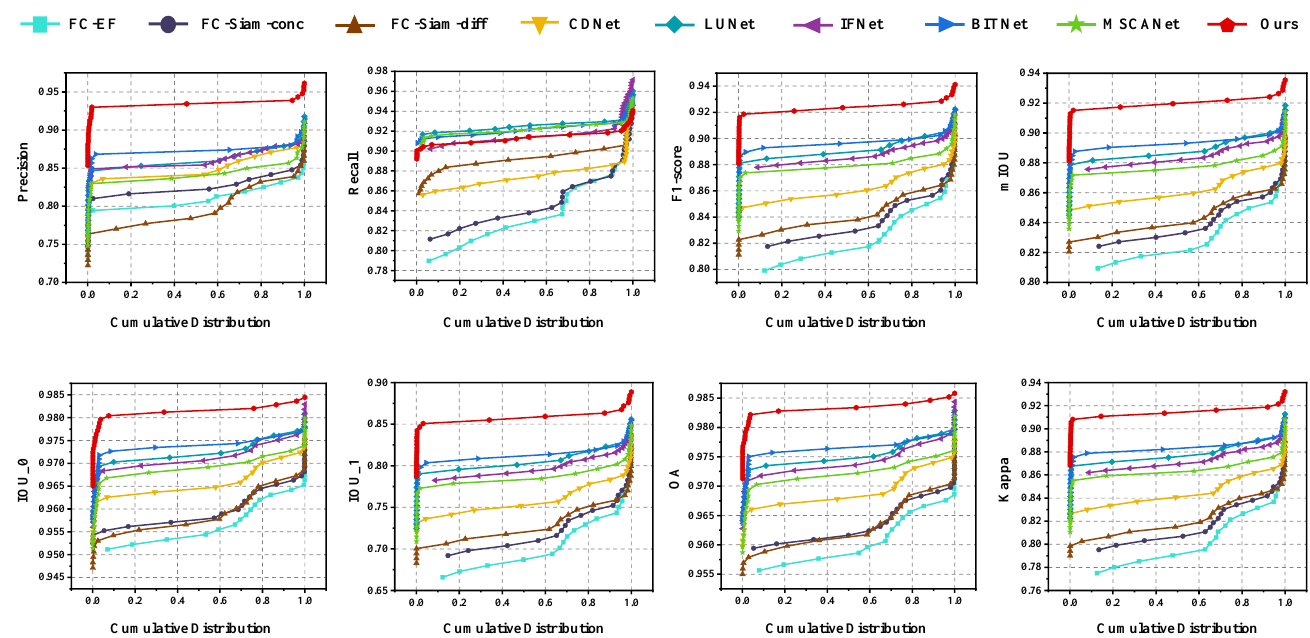
Figure 11. Eight metrics results of cumulative distribution curves for 921 images from the LEVIR-CD dataset.